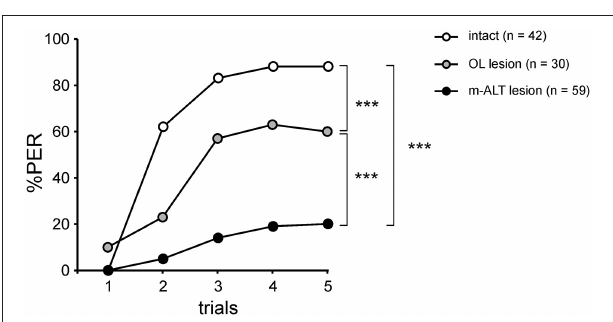
FIGURE 6 | PER conditioning performances in the three experimental groups. Acquisition performances are significantly lower in bees with an OL lesion than in intact bees, showing an effect of surgery ( *** p < 0.001 , Mann-Whitney test). PER conditioning performances are much weaker in bees with an m-ALT lesion than in bees with an OL lesion ( *** p < 0.001 , Mann-Whitney test), demonstrating a specific effect induced by the m-ALT PN